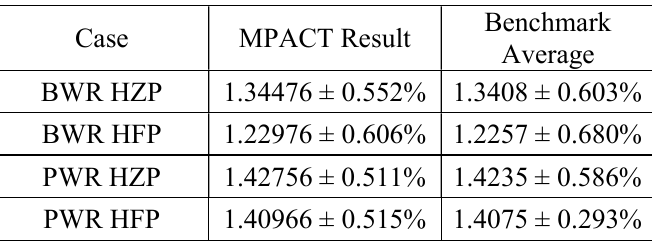
Table II. Pincell results: Effective neutron multiplication factor with uncertainty calculated by MPACT